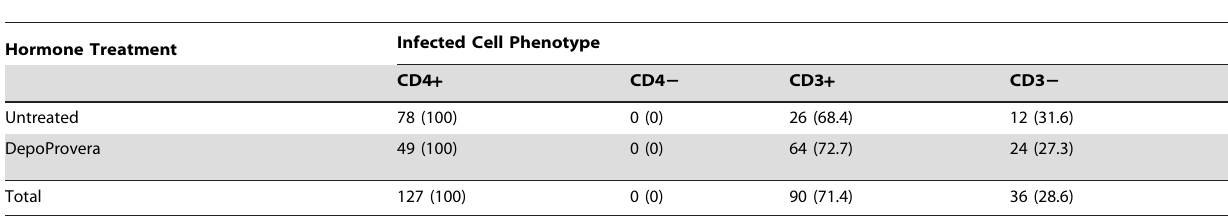
Table 3. Phenotype of SIV infected cells after inoculation JRFL pseudotyped virions.